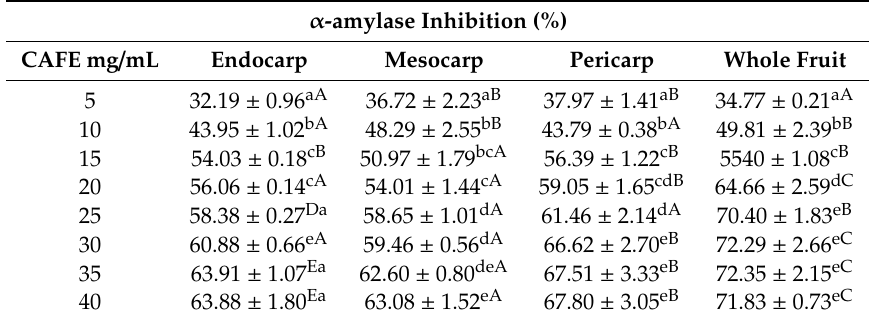
Table 2. E ff ect of the extracts from di ff erent parts of cactus acid fruit (endocarp, mesocarp, pericarp, and whole fruit) in the inhibition α -amylase